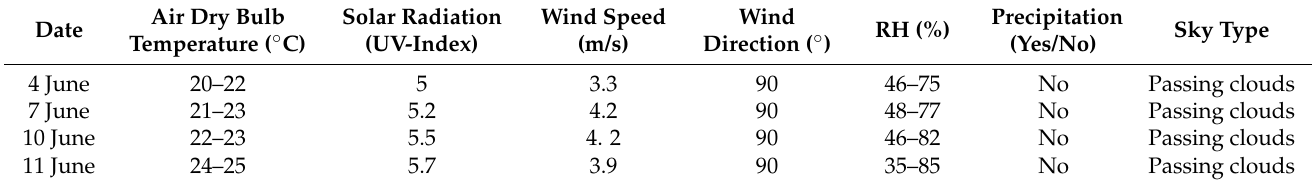
Table 5. Selected days for CFD simulation, based on the survey. Microclimatic data of Taltech campus in June 2021.